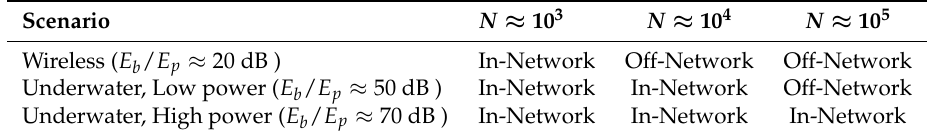
Figure 6. D in versus E b / E p , N , L = 8, ρ CS = 0.25, ρ enc = 0.025. Table 4. Most efficient architecture for different IoT network scenarios ( ρ CS / ρ enc = 20 dB, L =